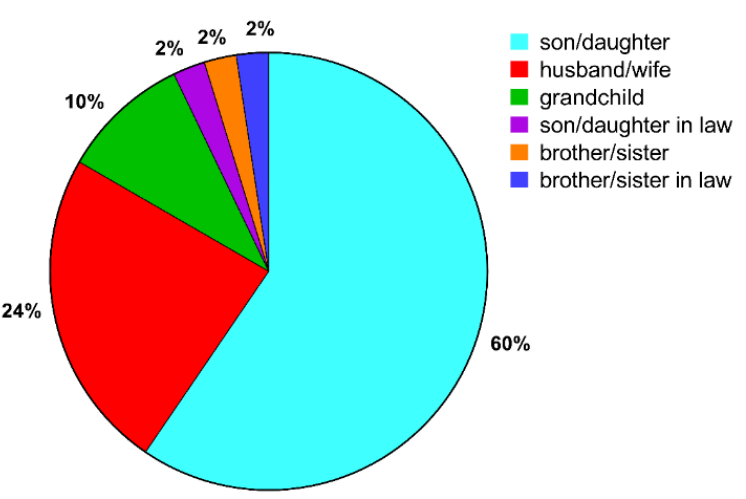
Figure 2. Relationship status caregiver-patient.